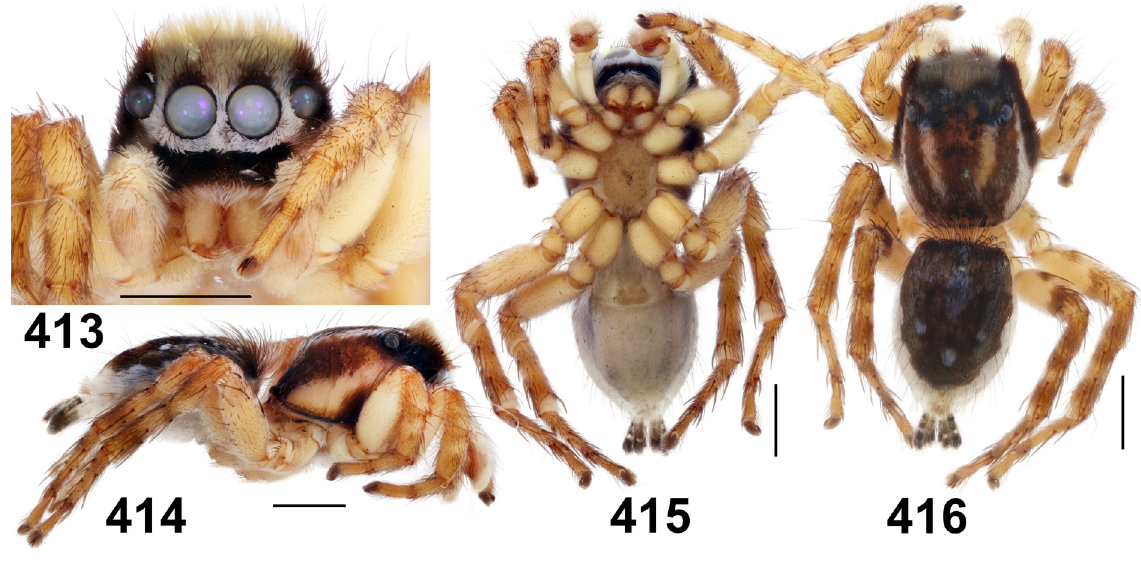
Figs 413–416. Stenaelurillus pilosus Wesołowska & Russell-Smith, 2011, holotype, ♂, general appearance. Scale bars: 1